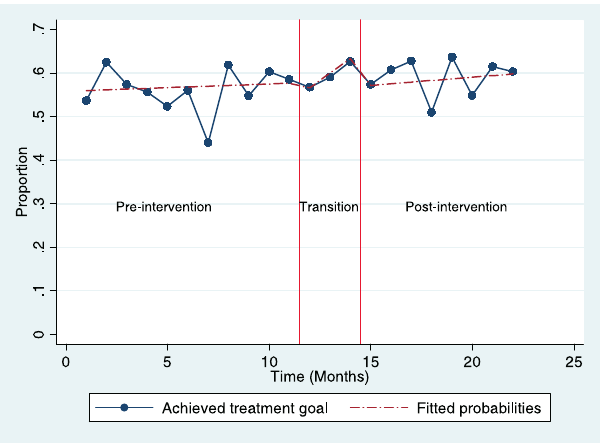
Figure 4. Proportion of Patients Receiving a Second Antihypertensive Drug within 4 mo of Starting Treatment for Uncomplicated